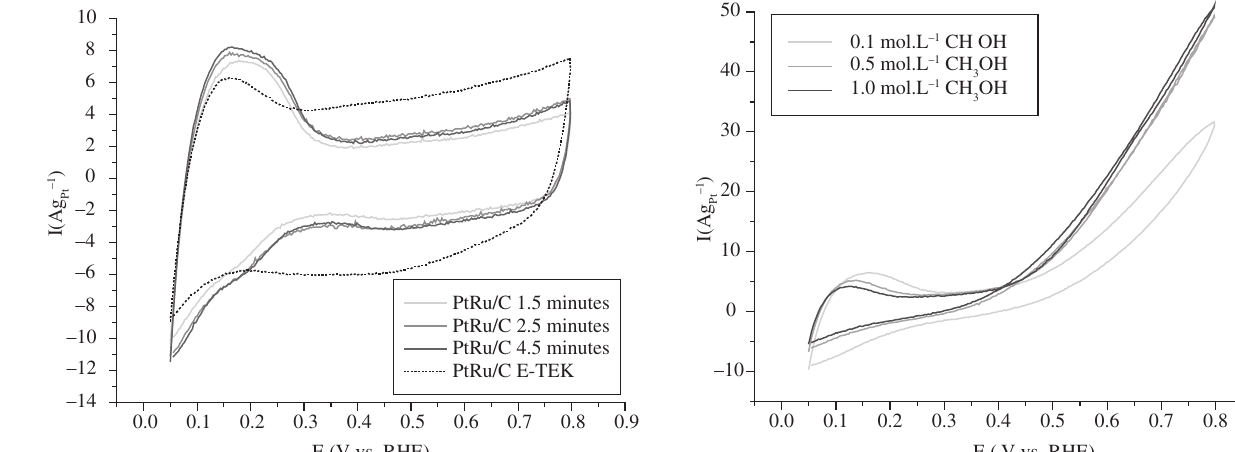
SO containing dif- 2 4